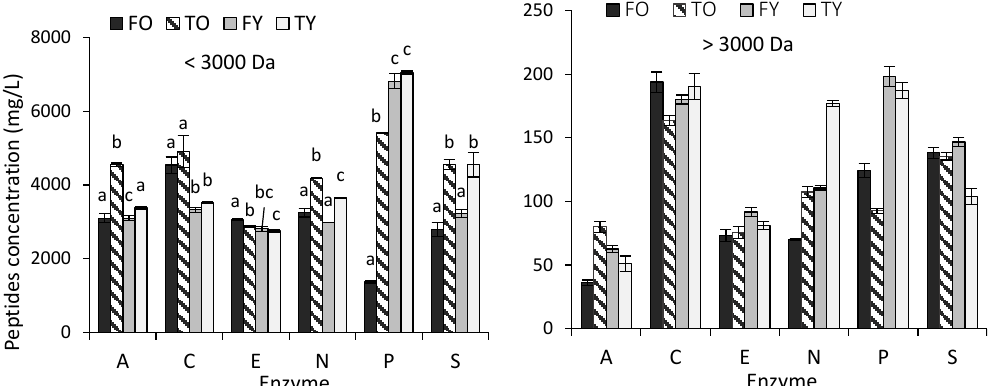
Figure 1. Concentration of peptides, < 3000 Da ( left ) and > 3000 Da ( right ) (equivalents of collagen, mg / L) from young and old bovine femur and tibia collagen solutions hydrolysed through the enzymes alcalase (A), collagenase (C), esperase (E), neutrase (N), papain (P), savinase (S) (mean values ± standard deviation (SD), n = 3). For each enzyme, significant di ff erences among bones ( p < 0.05) are indicated by di ff erent lowercase letters (only for the left Figure). FO = old femur, 10 years; TO = old tibia, 10 years; FY = young femur, 4.5 years; TY = young tibia, 4.5 years.